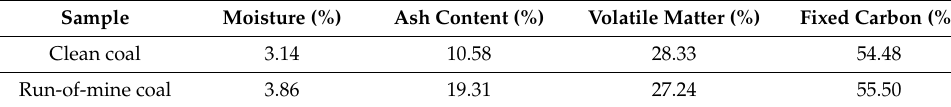
Table 1. The proximate analysis of the coal sample (air-dried basis).